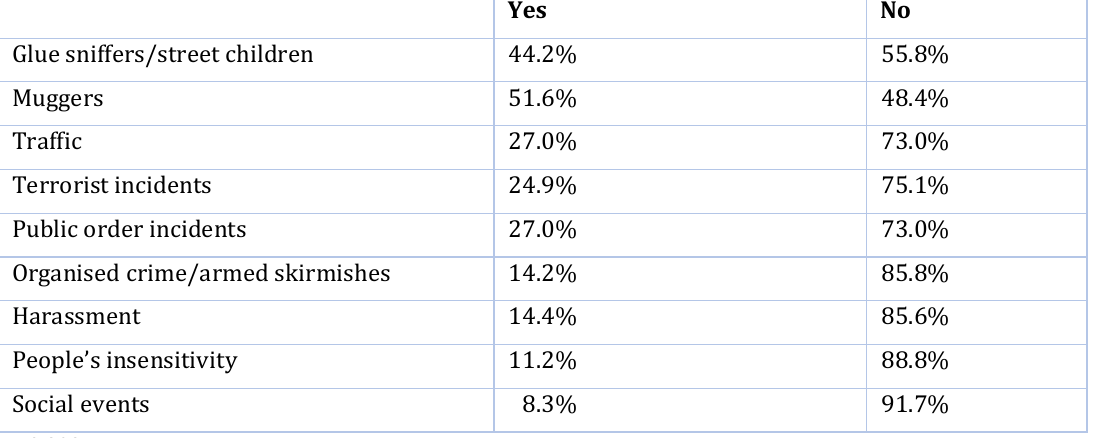
Table 2: Three issues that cause worry in the neighbourhood What are the three things that cause you most worry in the area where you